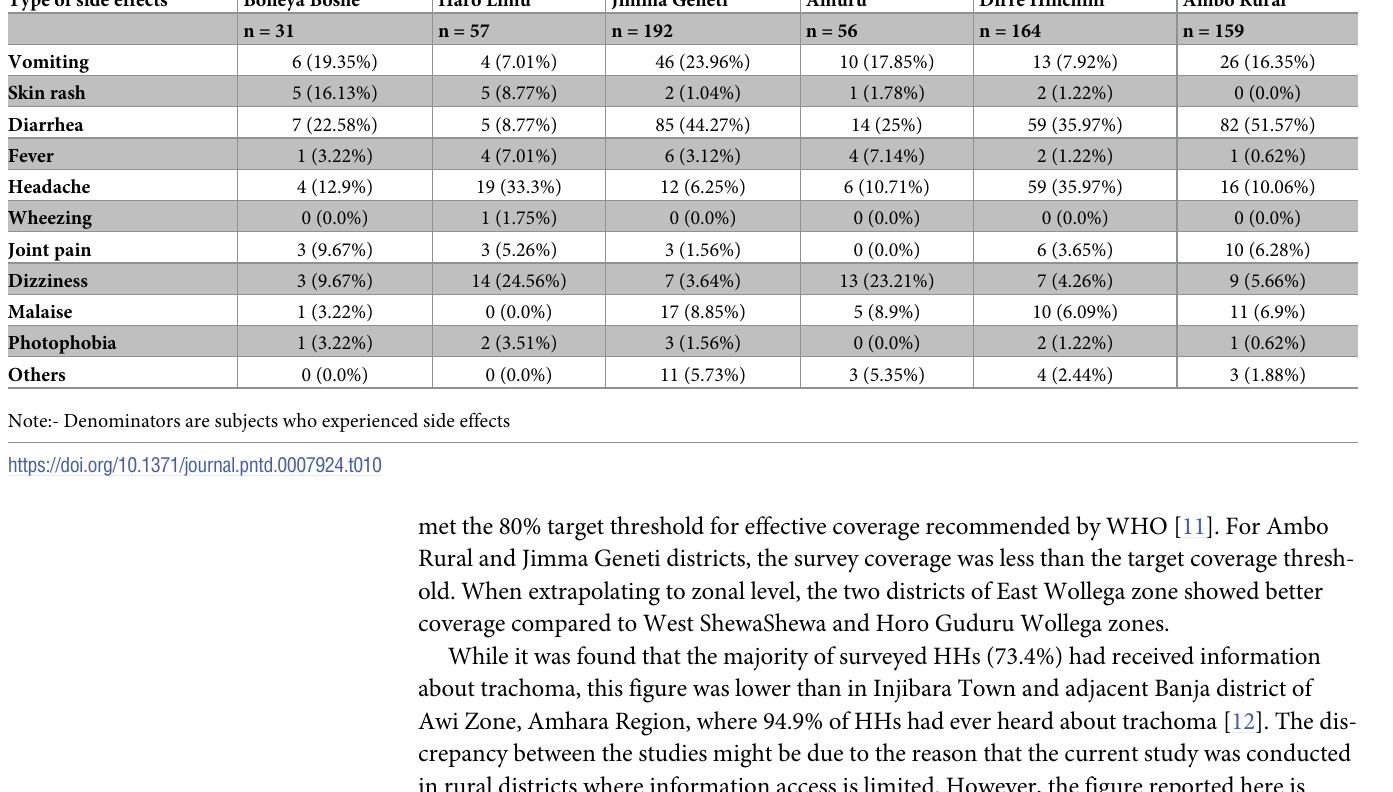
Table 10. Type of side effects of MDA, mass drug administration for trachoma coverage survey of six districts in East Wollega, West Shewa and Horo Guduru Zone, Oromia 2017. Type of side